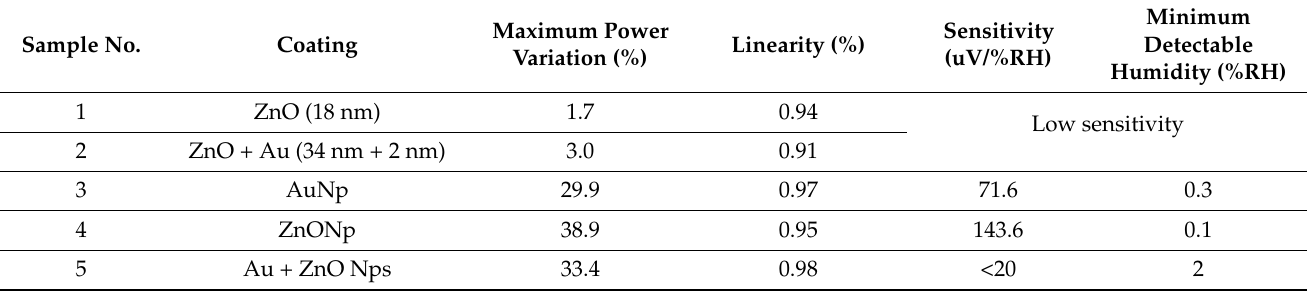
Table 2. Summary of the performance characteristics of the humidity